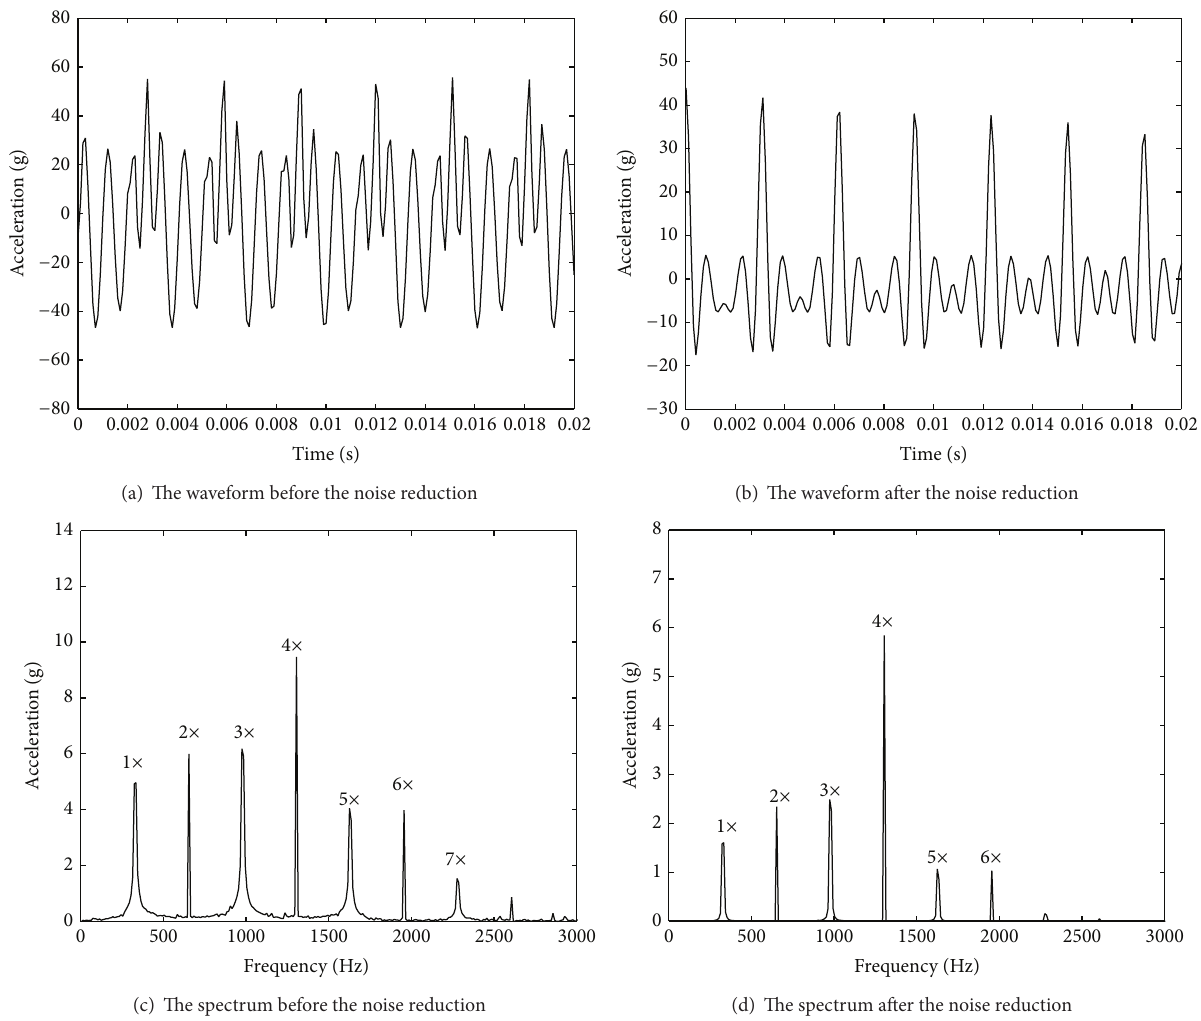
Figure 9: Time domain waveform and frequency spectrum before and after the noise reduction when the rotating speed is 19500